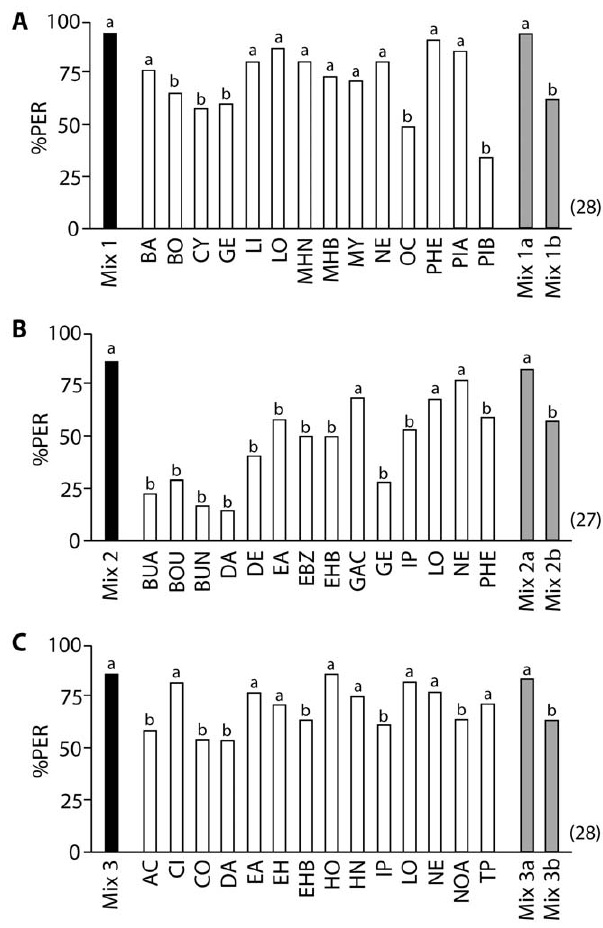
Figure 2. Key Odorant Signatures for Complex Scents. The ordinate represents the percentage of proboscis extensions (PER) to the training mixture (black bars), to the individual test odorants of which the mixture was composed (white bars), to a mixture of the key odorants (first grey bar), and to a mixture of non-key-odorants (second grey bar). The numbers in brackets indicate the numbers of bees trained and tested in each experiment. Different letters above bars (a or b) indicate significant differences between PER to the training mixture and to the individual odorants/key odorant mixture/non-key-odorant mixture (McNemar test [2 6 2 Table], Bonferroni corrected threshold p , 0.0036). (A) Bees were trained to mixture 1, and responded well to nine key odorants; (B) bees were trained to mixture 2, and responded well to three key odorants; (C) bees were trained to mixture 3, and responded well to eight key odorants. For composition of the training mixture, key odorant mixture, and non-key-odorant mixture see Table 2. Odorants are listed alphabetically by their abbreviations; for corre- sponding odorant names, see Table 1.